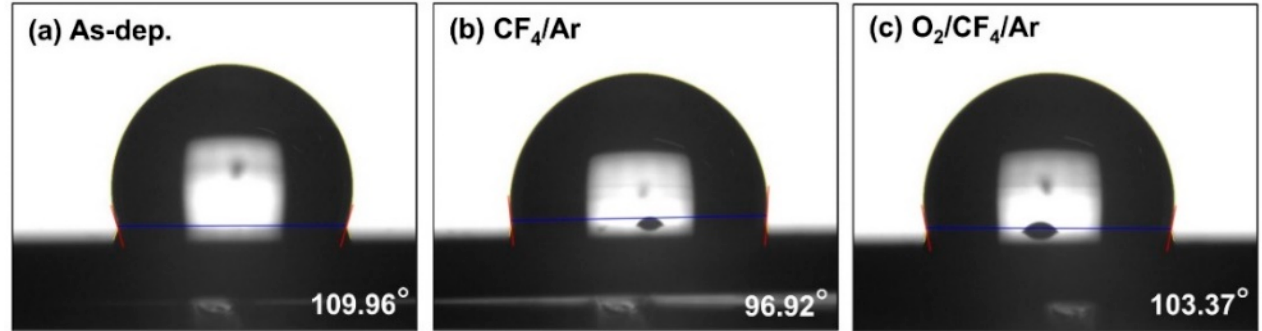
Figure 6. Contact angle value and droplet profiles of IGZO thin film surfaces as a function of additive O 2 concentration with fixed CF 4 /Ar = 25:75 sccm. ( a ) As-deposited IGZO thin film; IGZO thin film etched using ( b ) CF 4 /Ar plasma and ( c ) O 2 /CF 4 /Ar plasma.